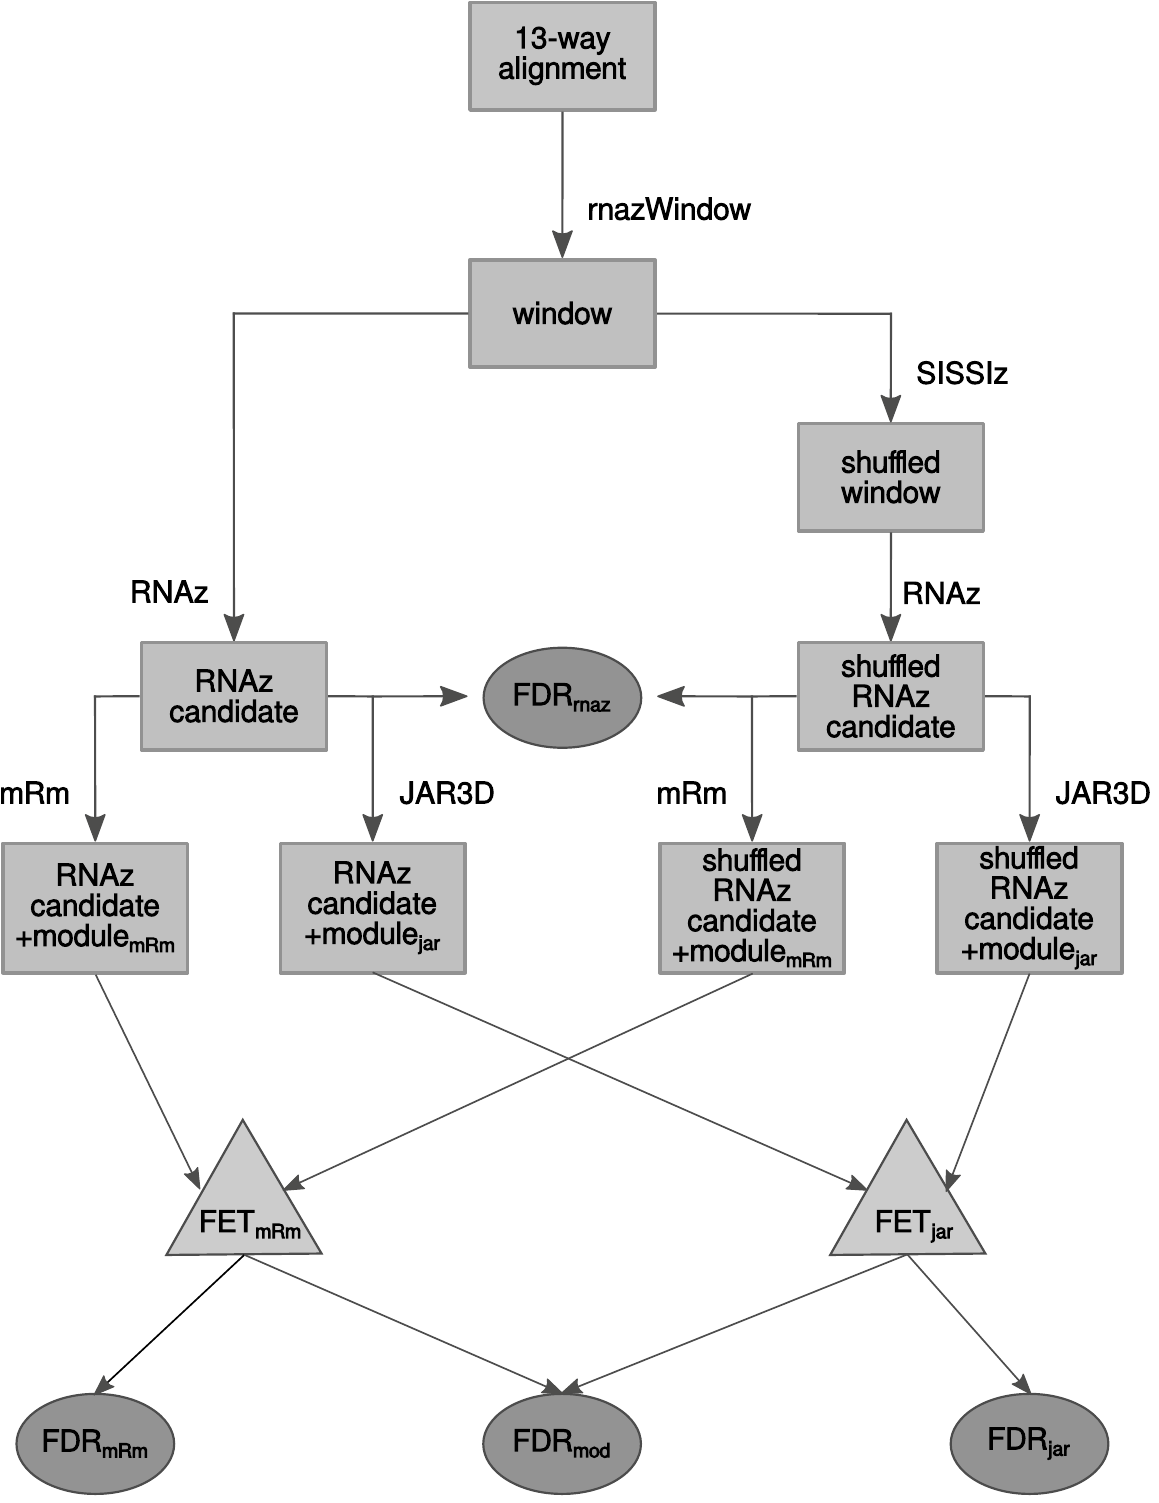
Fig 1. Graphical outline of the approach. The 13-way alignment is sliced into windows of size 40 – 120 nts. The windows are shuffled by SISSIz and both the original and shuffled data are scanned by RNAz for thermodynamically stable and evolutionarily conserved candidates (p-score > 0.9). For those windows the false discovery rate is estimated (FDR rnaz ). Both the original and shuffled windows are also scanned by metaRNAmodules (mRm) and JAR3D for reliable